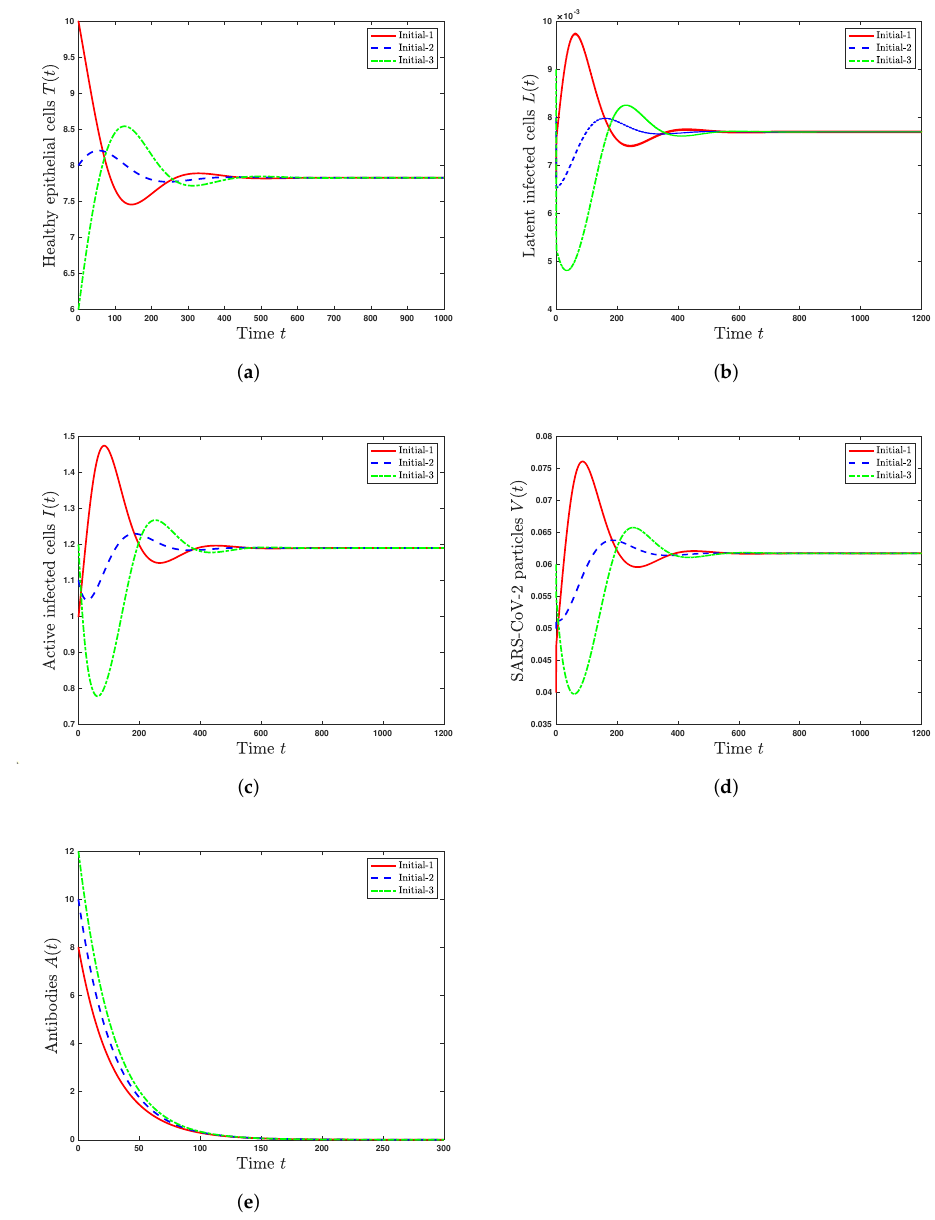
Figure 2. Solutions of system (19)–(23) with three initial conditions when R 1 ≤ 1 < R 0 and rT 1 > 0. ( a ) Healthy epithelial cells; ( b ) latent infected cells; ( c ) active infected cells; d 1 − r + T max ( d ) SARS-CoV-2 particles; ( e )